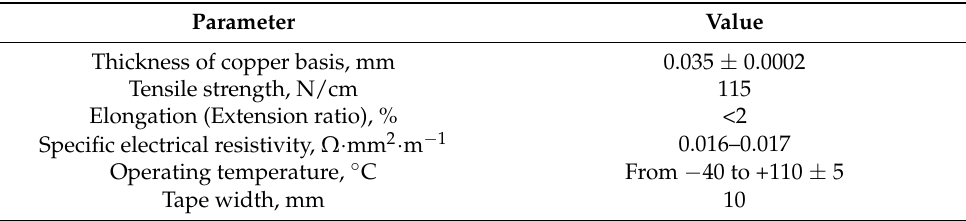
Figure 2. ( a ) Developed sandwich-type coating (schematic presentation of Sandwich “Copper tape + Silver Adhesive”, 2 layers); ( b ) Copper tape. Table 5. Parameters of copper tape.